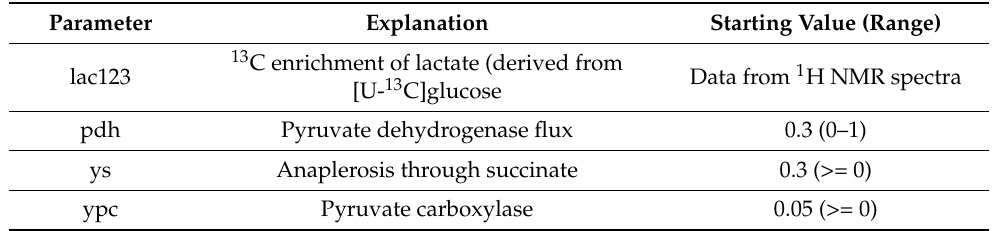
Table 1. Starting values and acceptable ranges (in parenthesis) of parameters used in metabolic modeling. 13 C enrichment of lactate is obtained from the methyl resonance. Starting values represent magnitude of fluxes relative to unitary citrate synthase